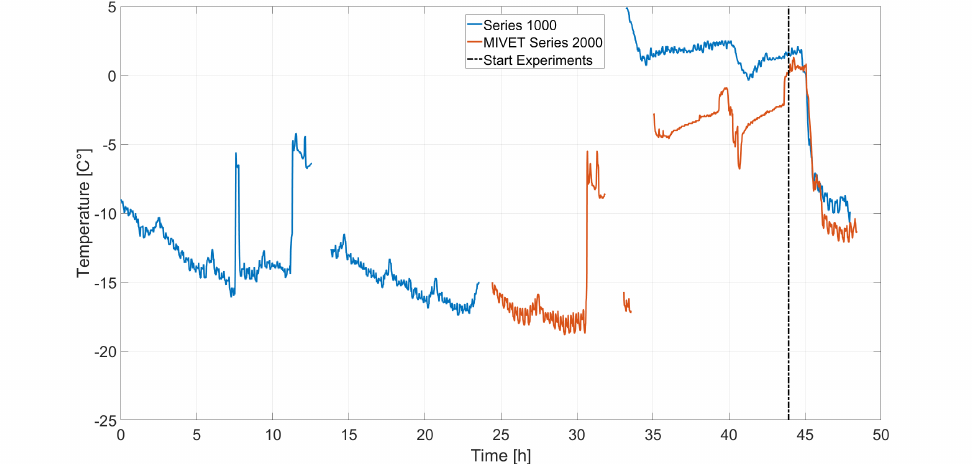
Figure 2. Temperature history of the ice production process. The temperature rise in the tempering phase of both ice sheets is aligned for a better comparison. The temperature is measured ≈ 2m above the ice sheet. The gaps in the measurement history are caused by the retraction of the thermometer for operational